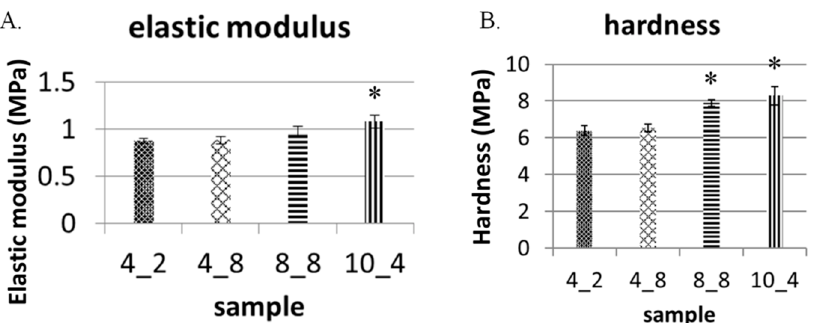
Figure 6. Mechanical strength measurement of PDMS/GO + GO scaffolds with different hexagonal micropillars. Elastic modulus and hardness were measured by nanoindentation. The bar charts showing elastic moduli ( A ) and hardness ( B ) of four classes of GO ‐ coated PDMS scaffolds with hexagonal micropillars. The results are the mean ± SD of three independent experiments. In panels A and B, * p < 0.05 versus sample 4_2.